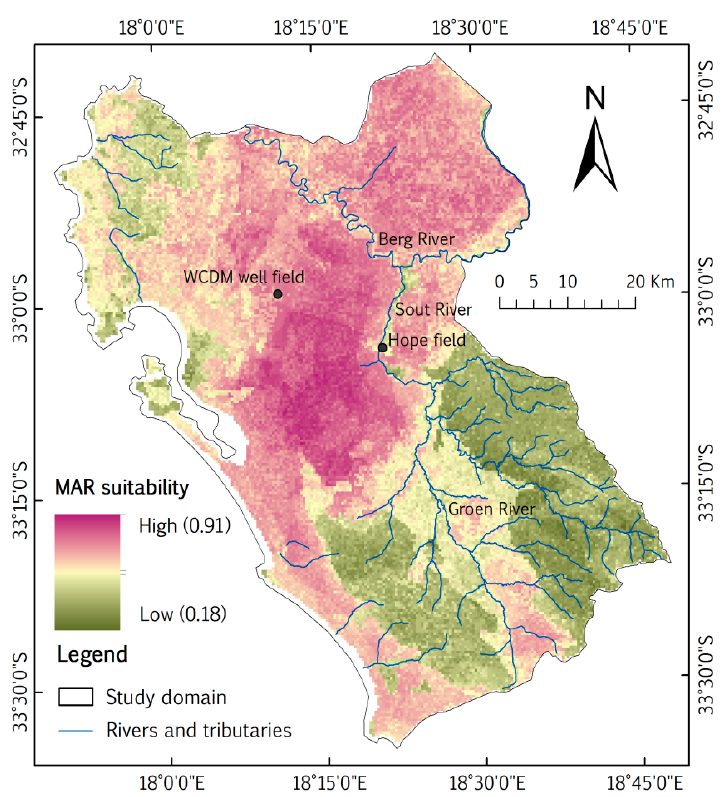
Figure 9. Suitable sites map integrated by the GIS based analysis.